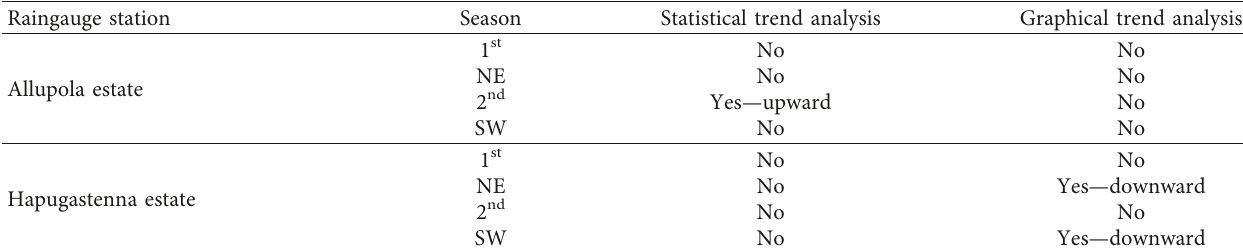
Table 6: Comparison results for seasonal rainfalls for Denawaka Ganga